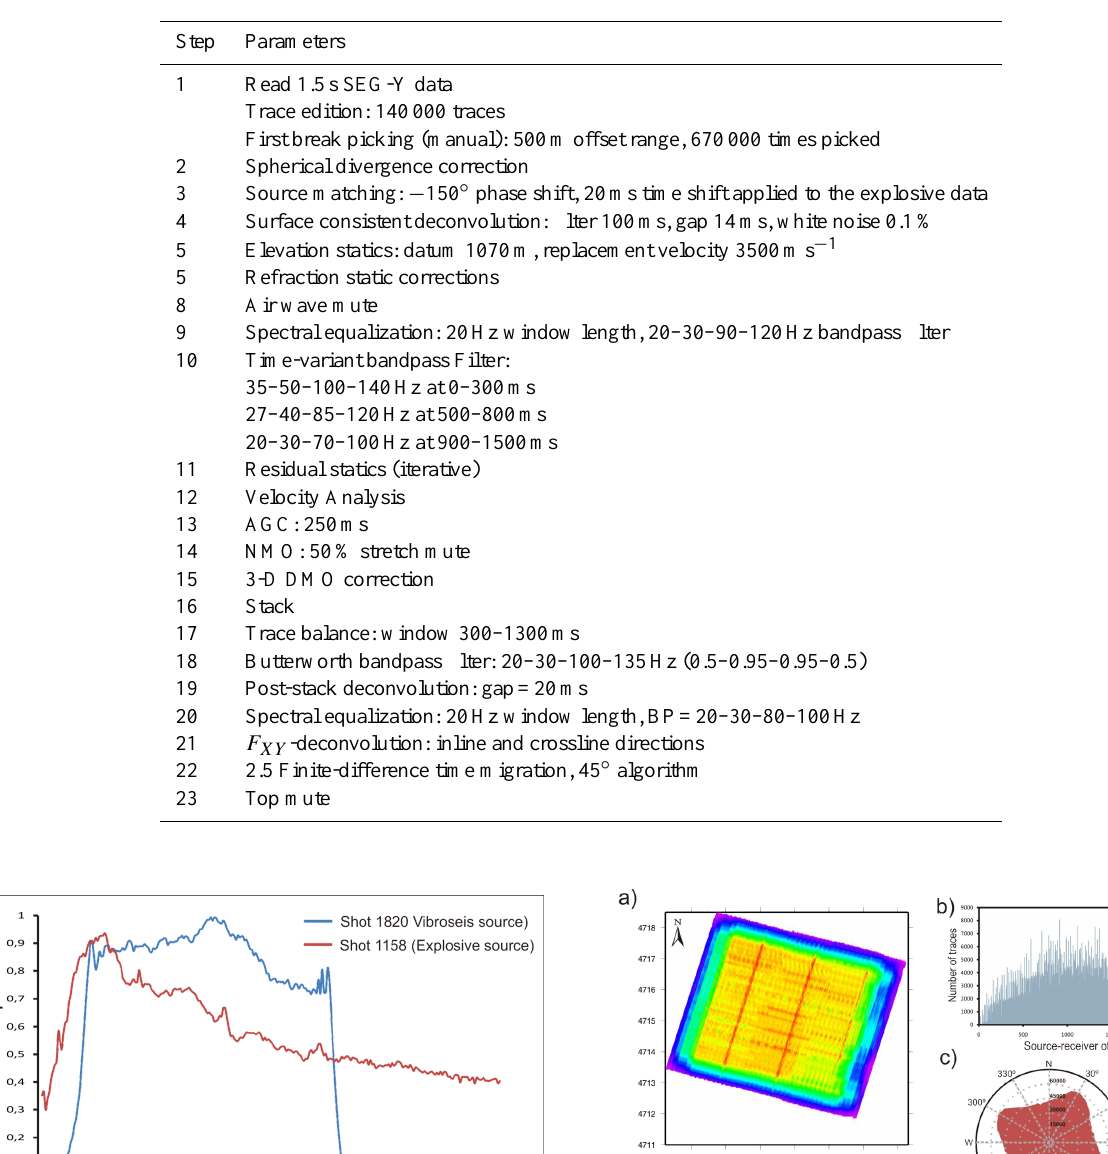
Table 2. Processing steps applied to the seismic data set.